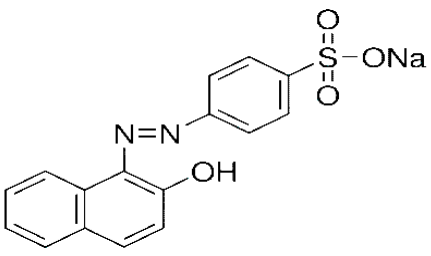
Figure 18. Orange II chemical structure.